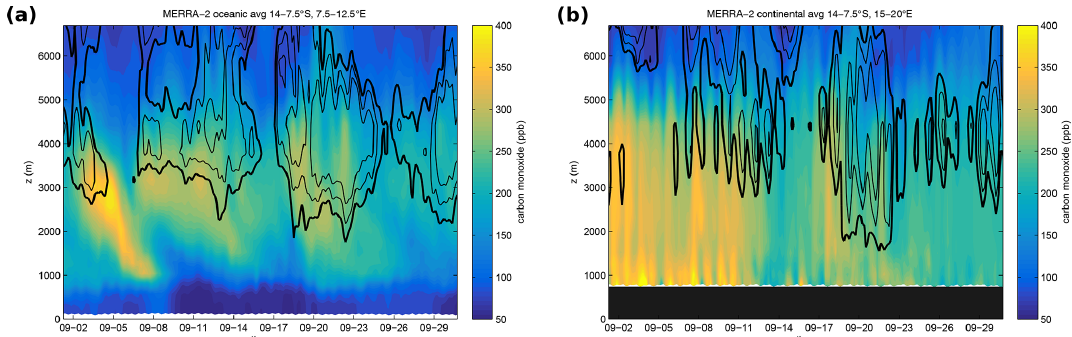
Figure 11. Oceanic (a) and continental (b) CO (shaded) overlaid with zonal wind speed (black contours) from the MERRA-2 reanalysis. The thick black lines indicate the threshold of the AEJ-S (6m/s) with thin lines showing 8 and 10m/s easterly